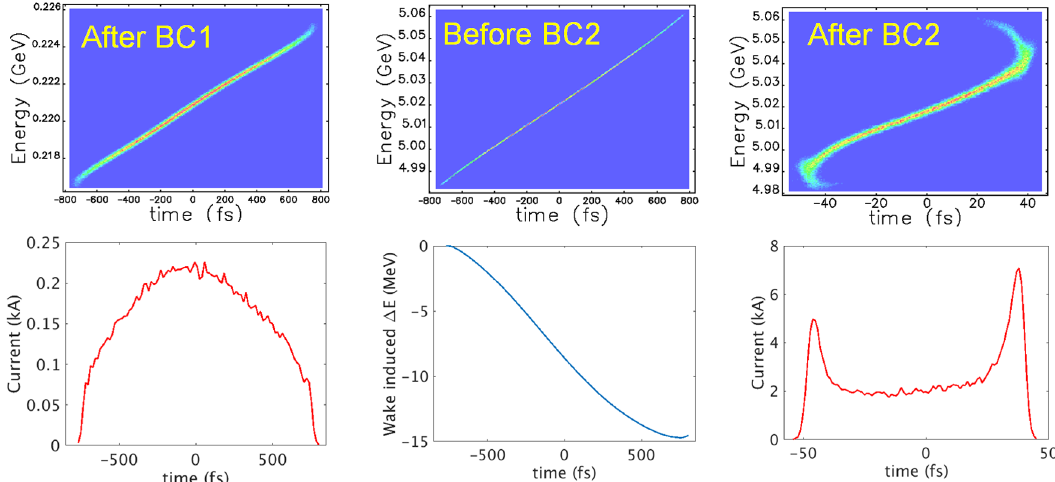
FIG. 2. Simulation examples of a regular beam without collimation, bunch charge 250 pC. Left column: electron beam longitudinal phase space and current profile after BC1 chicane. Middle column: longitudinal phase space before BC2 chicane and L2-linac wake induced energy change. Right column: longitudinal phase space and current profile after BC2